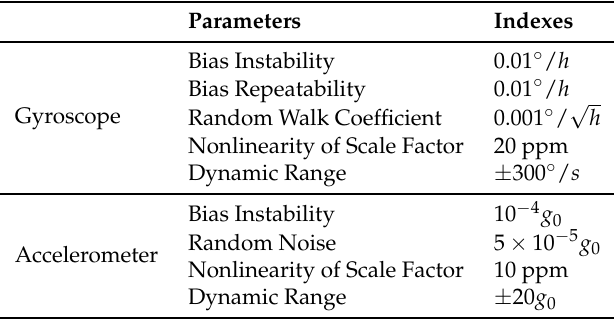
Table 1. Performance of the tested IMU.